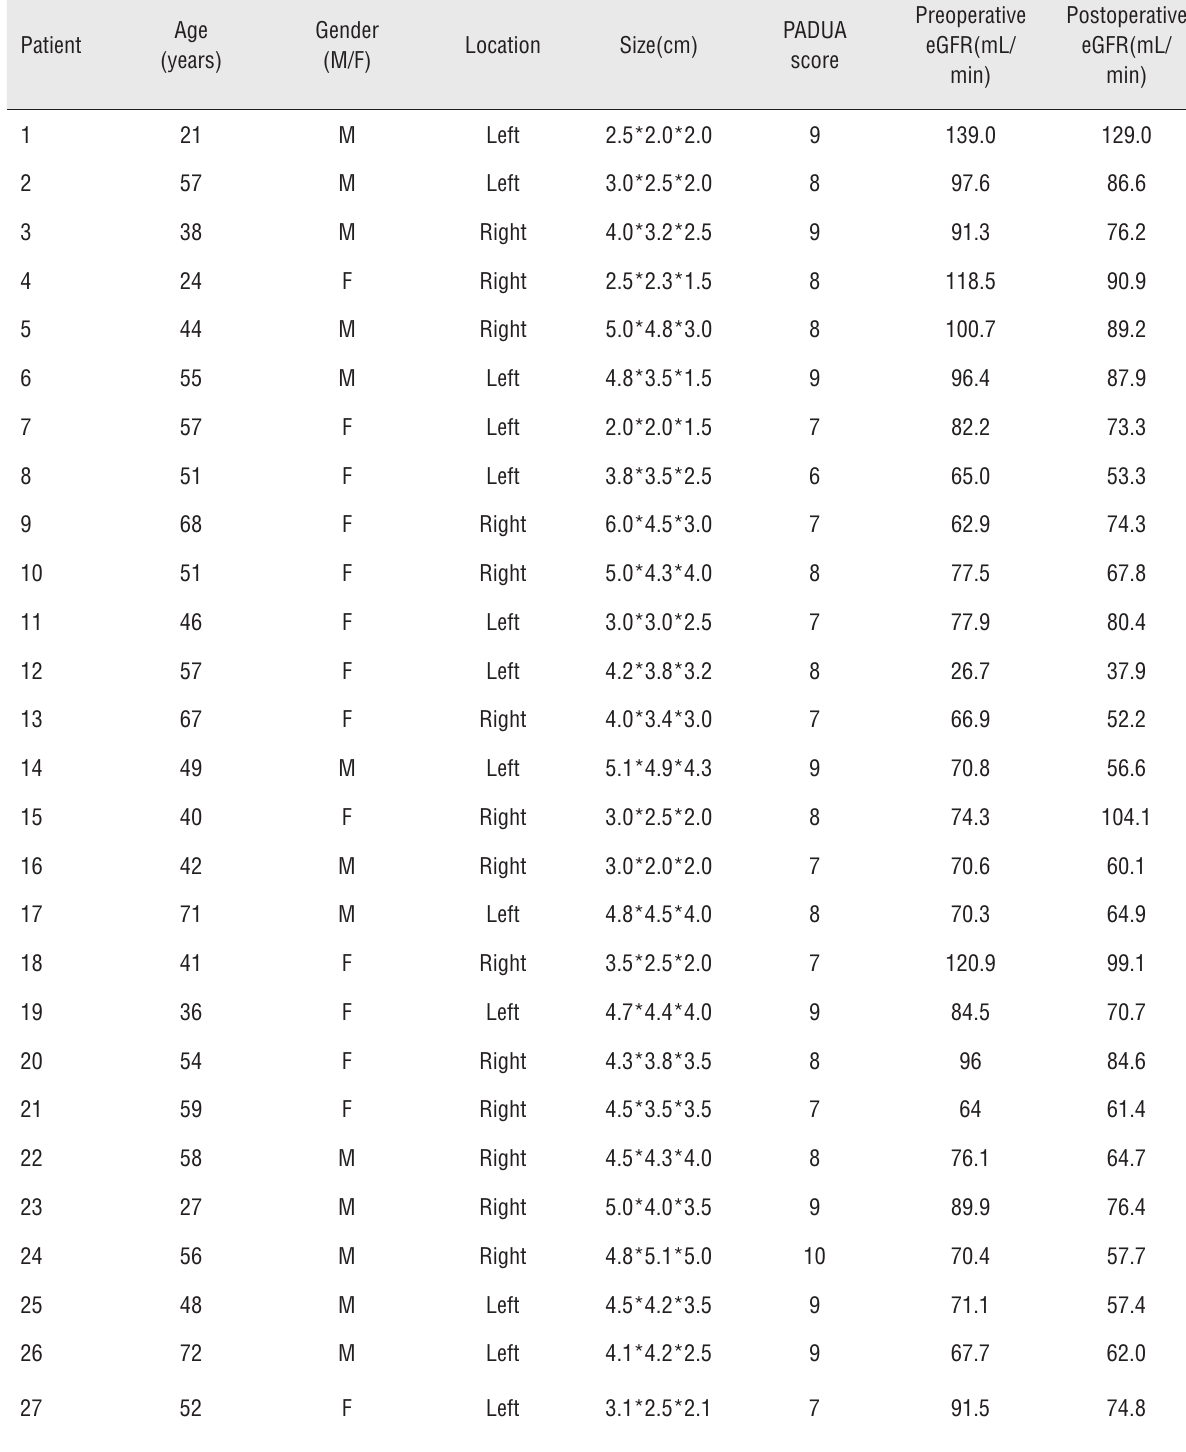
Supplemental table. characteristics of the patient